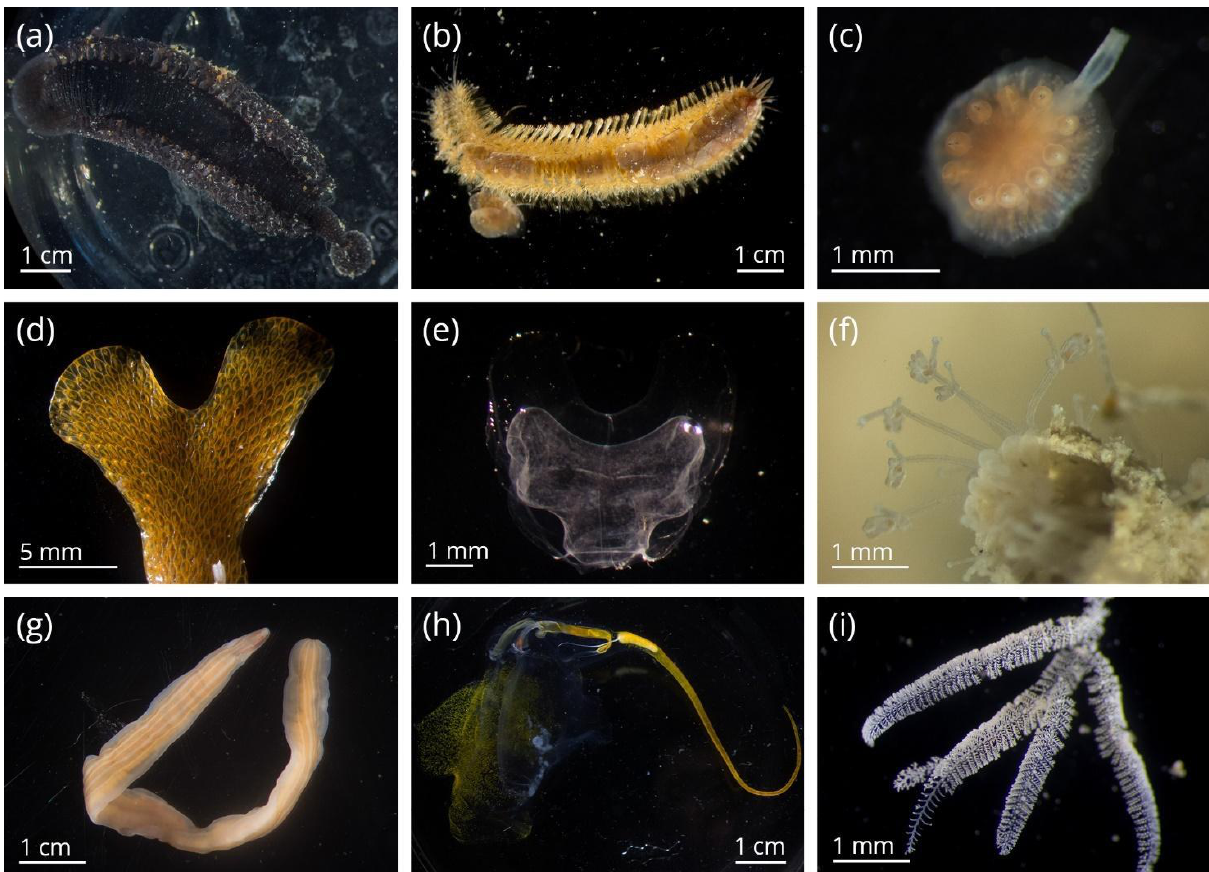
Figure 5. Photos of selected new records under a dissection microscope, in vivo. ( a ) Branchellion torpedinis ; ( b ) Harmothoe pagenstecheri ; ( c ) Myzostoma glabrum ; ( d ) Chartella ind; ( e ) nectophore of Halistemma rubrum ; ( f ) Proboscidactyla ornata ; ( g ) Gibsonnemertes spectabilis ; ( h ) Helicosalpa virgula ; ( i ) Zoothamnium niveum .